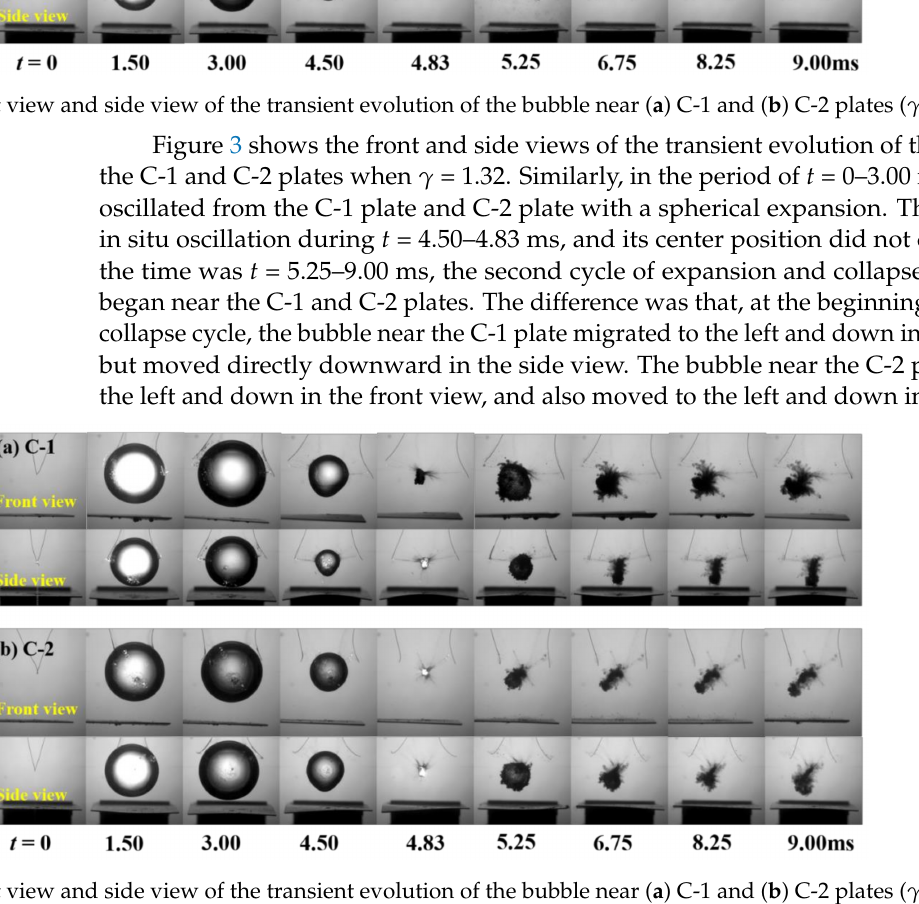
Figure 3. Front view and side view of the transient evolution of the bubble near ( a ) C-1 and ( b ) C-2 plates ( γ =